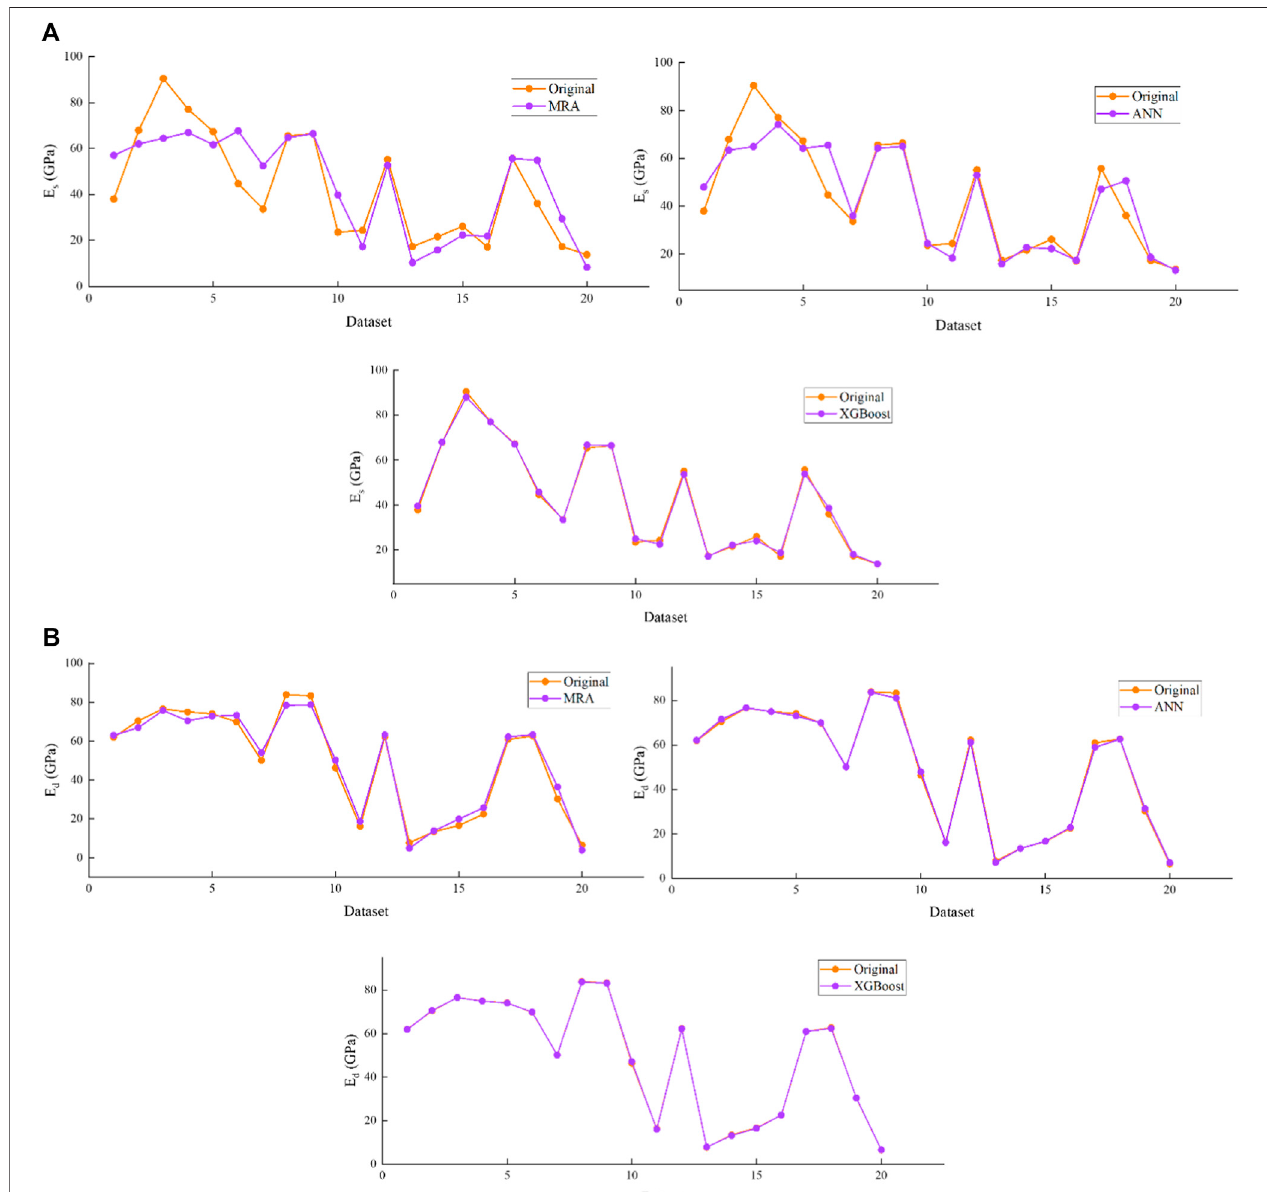
FIGURE 9 | Demonstration of predicted against original data of proposed models in the testing stage for (A) E s and (B) E d .